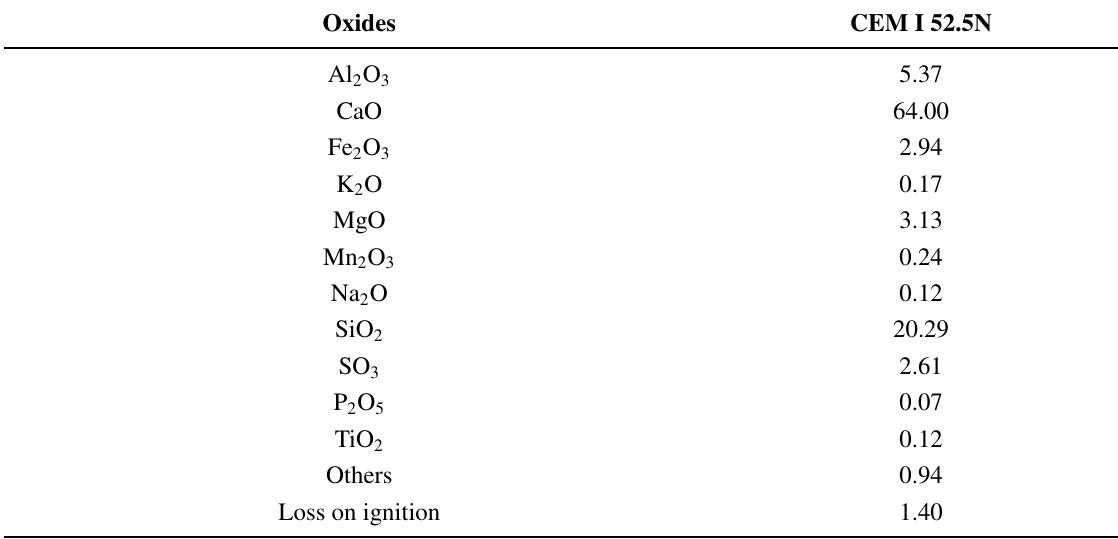
Table 2. Chemical composition of ordinary Portland cement (CEM I)